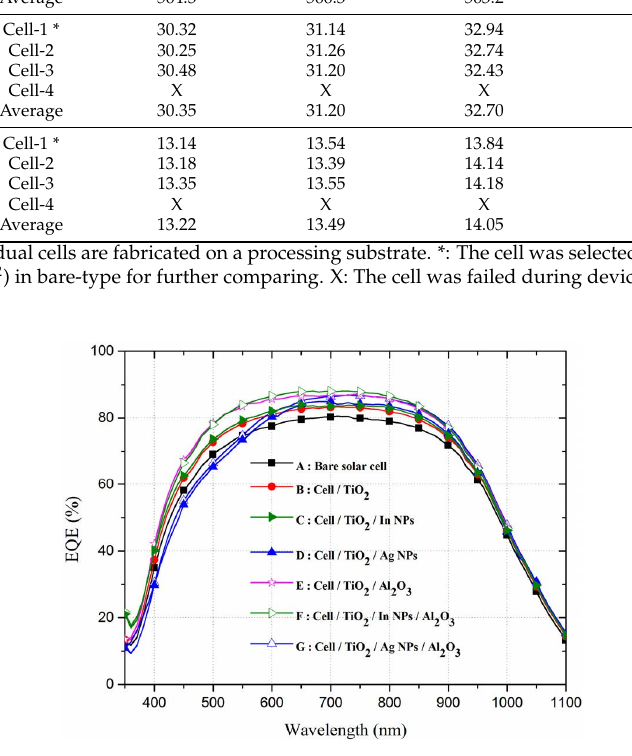
Figure 6. External quantum efficiency (EQE) response of bare textured c-Si solar cell, cell with TiO 2 spacer layer, cell with double layer of TiO 2 /Al 2 O 3 , cell with In-NPs on TiO 2 spacer layer, cell with Ag-NPs on TiO 2 spacer layer, cell with In-NPs embedded in TiO 2 /Al 2 O 3 , and cell with Ag-NPs embedded in TiO 2 /Al 2 O 3 .